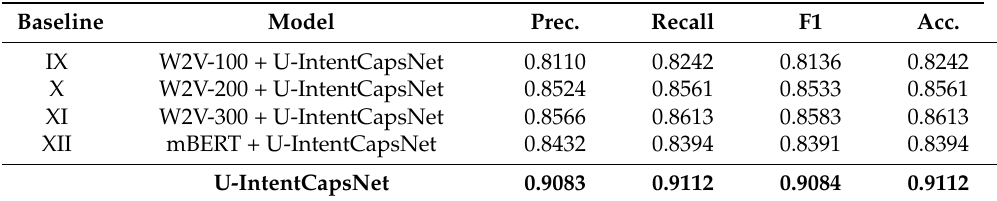
Table 11. Intent detection results for baselines with pre-trained word representations and the pro- posed U-IntentCapsNet model with an embedding layer trained from scratch.